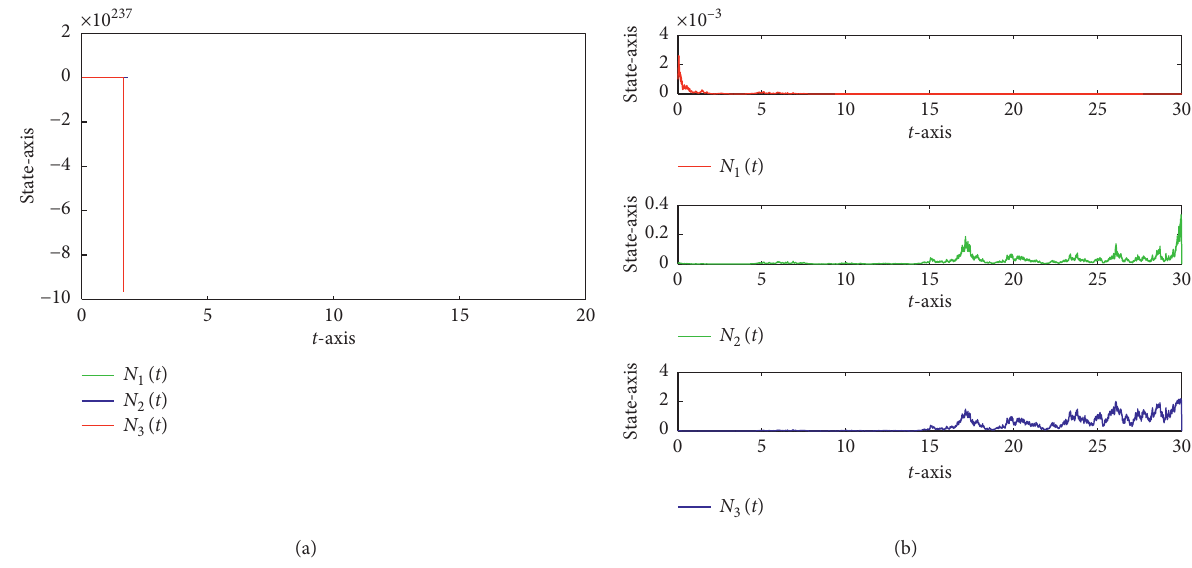
Figure 2: Unstable cases for (4) and (6) with large stochastic perturbations, respectively, which show that too large stochastic disturbances destroy the stability of above systems. (a) For system (4), with σ